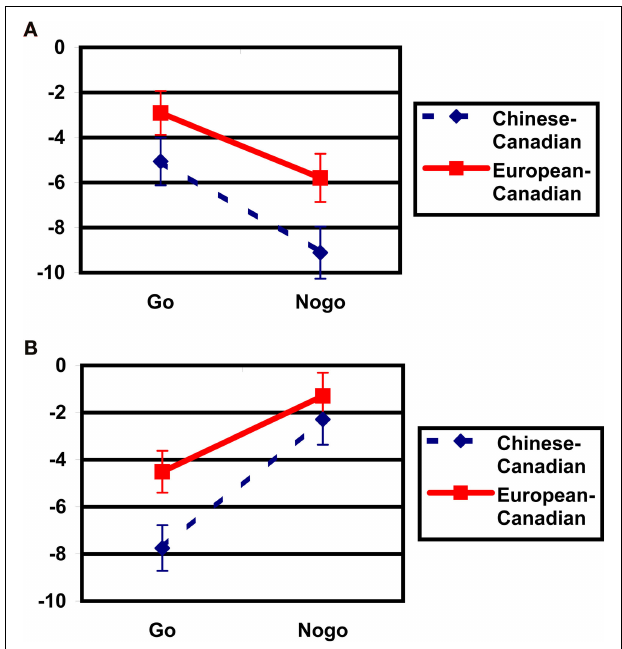
FIGURE 4 | Cultural group differences in N2 amplitudes (µV) by go/no-go condition. (A) Mean amplitudes for the right-hemisphere fronto-central cluster of electrodes (Hydrocel electrodes 112, 111, 118, 117, and 124). (B) Mean amplitudes for the left-hemisphere fronto-central cluster of electrodes (Hydrocel electrodes 13, 29, 20, 28, and 24).